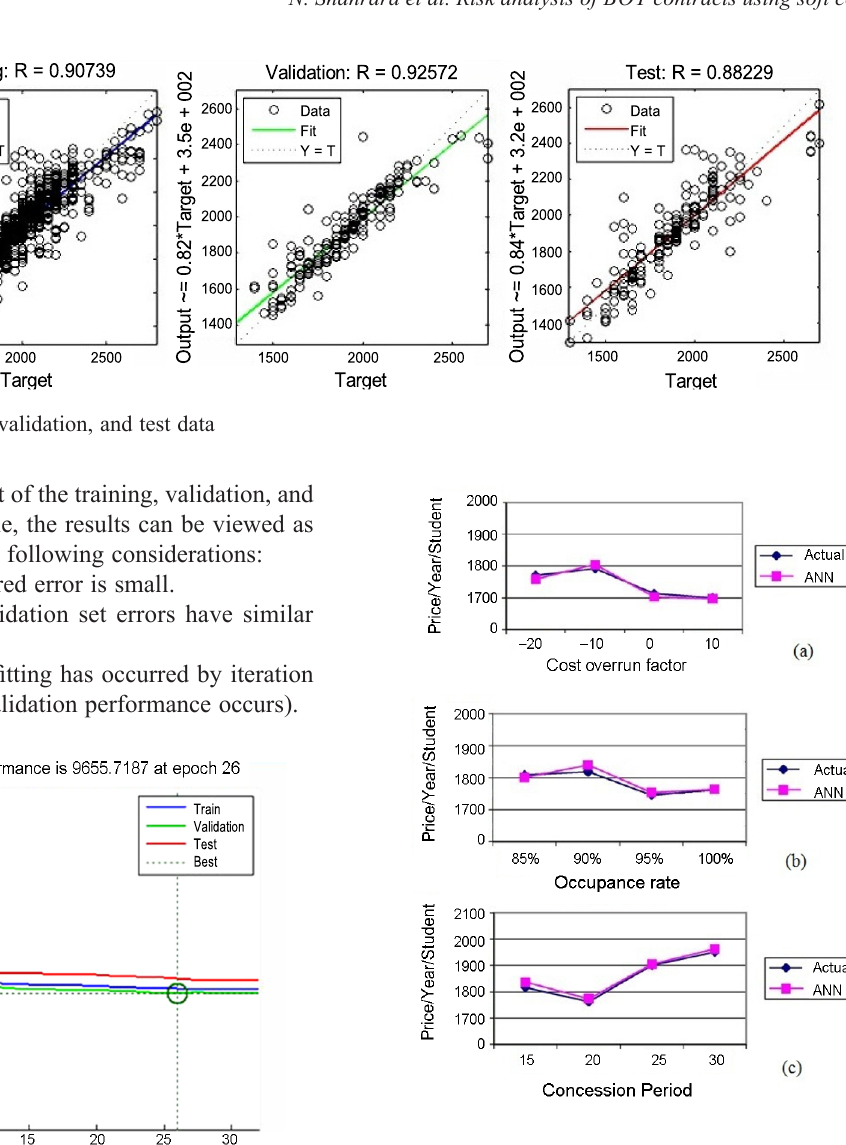
Fig. 6. Test data for evaluating price/year/student: (a) cost overrun factor; (b) occupancy rate; (c) concession period